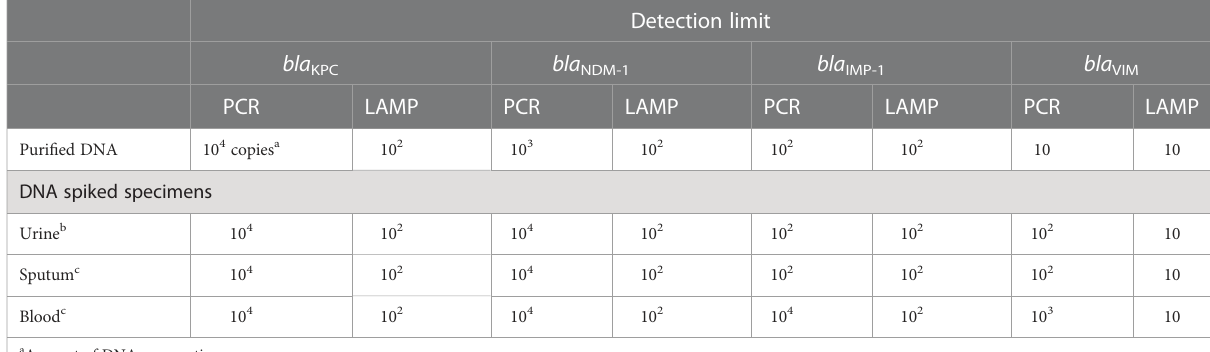
TABLE 4 Detection limits of the PCR and LAMP assays used to detect bla KPC , bla NDM-1 , bla IMP-1 and bla VIM in DNA-spiked